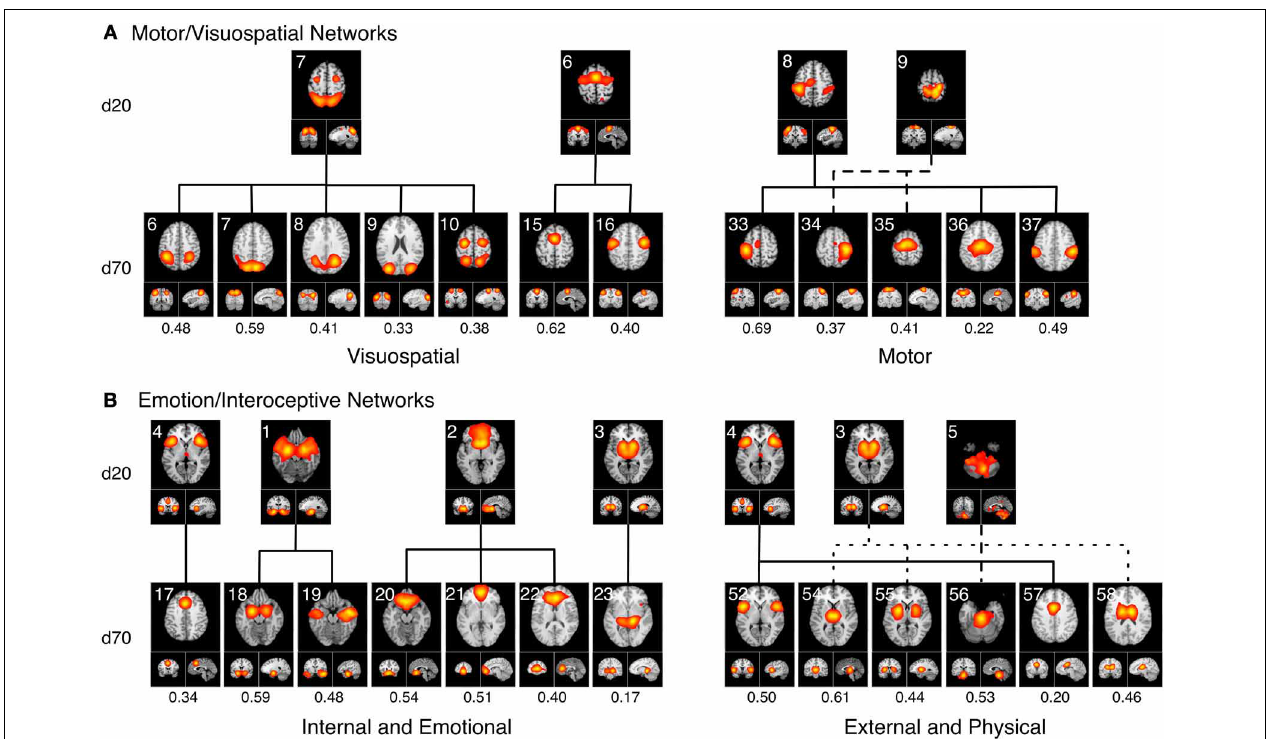
FIGURE 7 | Topological fractionation of select BrainMap-based ICNs are shown from low ( d = 20) to high ( d = 70) model orders. The spatial cross correlation between the d = 20 and d = 70 networks are indicated below each respective d = 70 network. (A) The Motor/ Visuospatial networks, which were grouped into one cluster at d = 20 (green ICNs in Figure 6 ), split into three separate clusters at d = 70. Metadata associated with these ICNs indicated that two clusters were more closely related to visuospatial tasks while the other cluster was